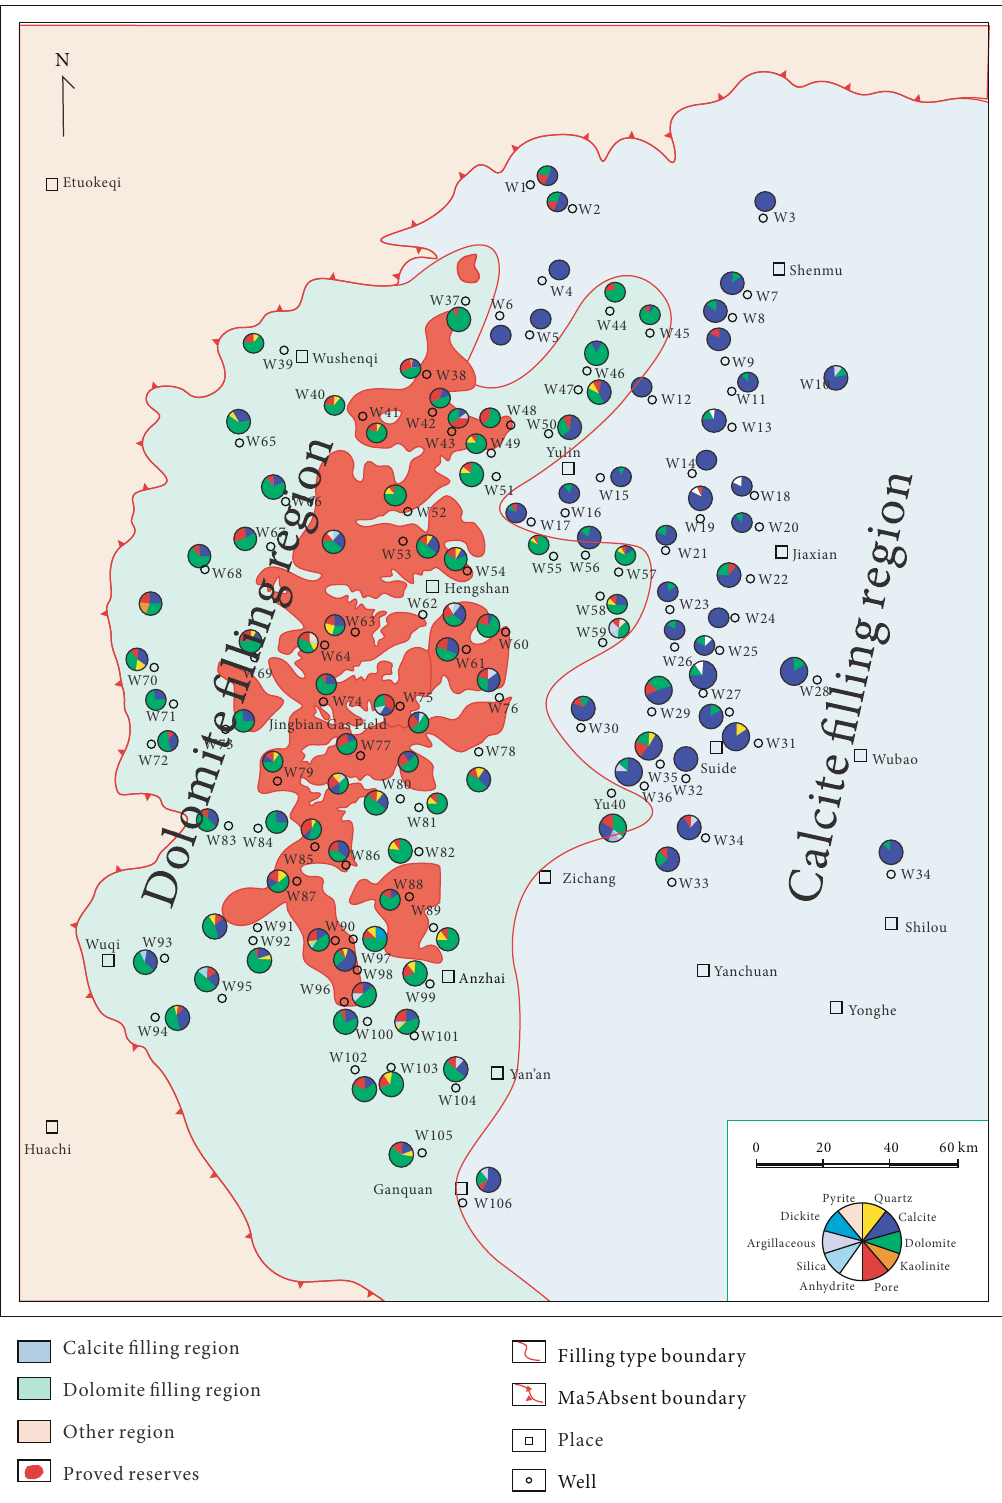
Figure 2: The distribution map of minerals fi lling in anhydrite dissolution pores in the Ordovician Majiagou Formation of Ordos Basin (modi fi ed from [21,